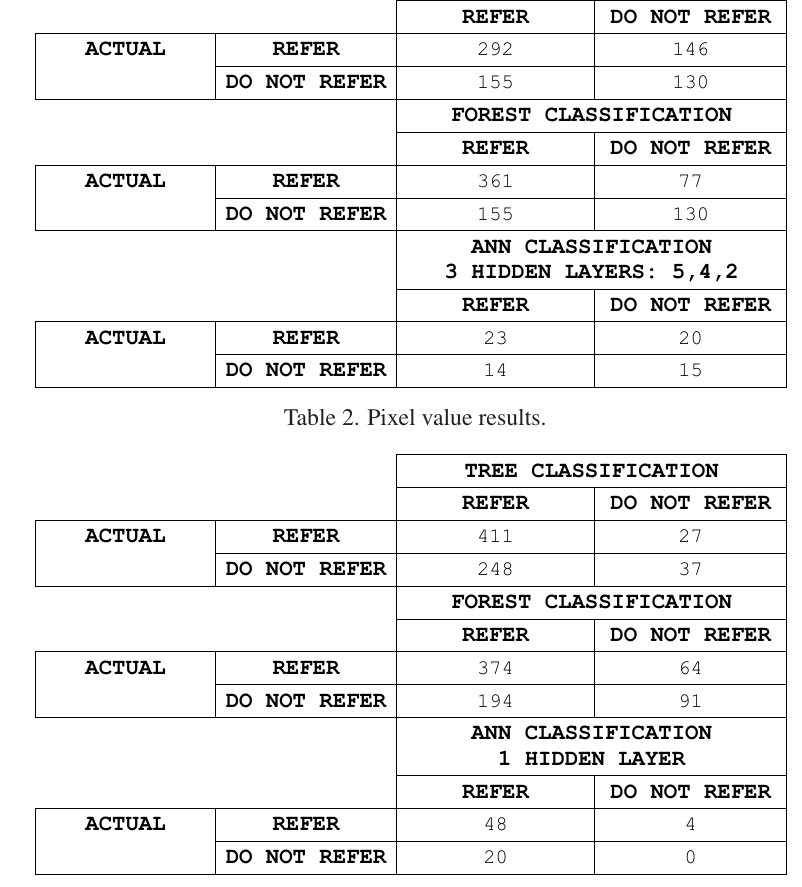
Table 3. PCA Pixel value results.